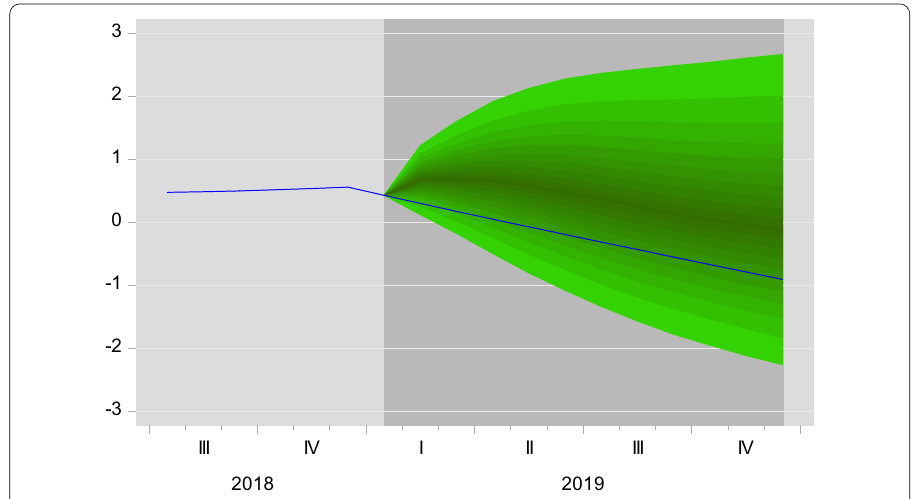
Fig. 1 Fan chart forecasting performance of VAR (2). Source : Authors’